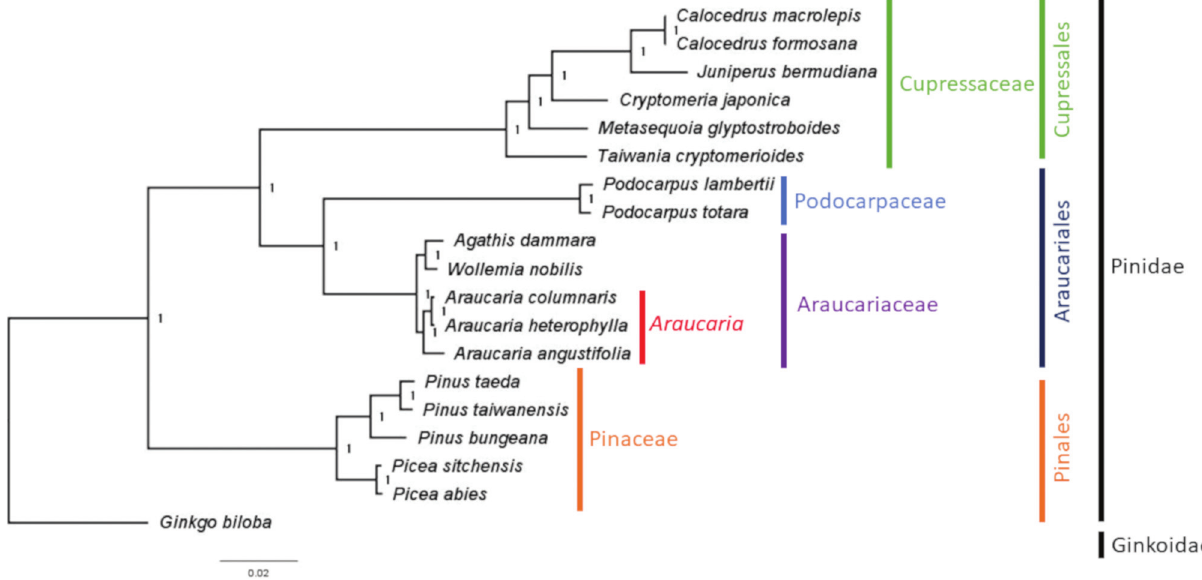
Figure 2 - Phylogenetic tree of 18 species of Pinidae based on 73 cp protein-coding genes generated by Bayesian method. Numbers above each node are posterior probability values. Family and order are also indicated. Ginkgo biloba was used as